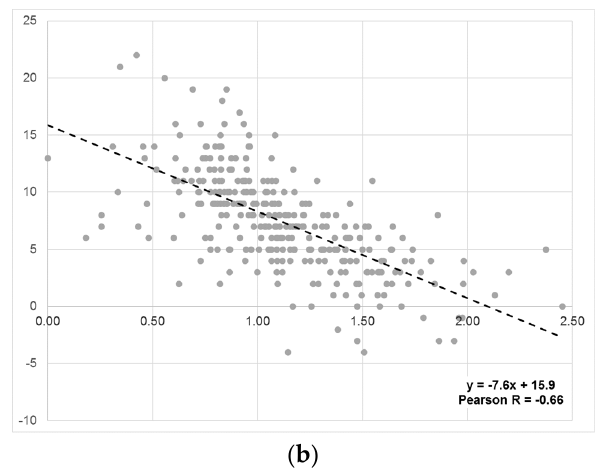
Figure 2. ( a ) Preoperative Thoracic Curve Ratio (PreTCR, X axis) vs. Preoperative T1 Tilt Angle ( Y axis). ( b ) Thoracic Curve Correction Ratio (Percent Correction Ratio/PreTCR, X axis) vs. Postopera- tive T1 Tilt Angle ( Y axis).